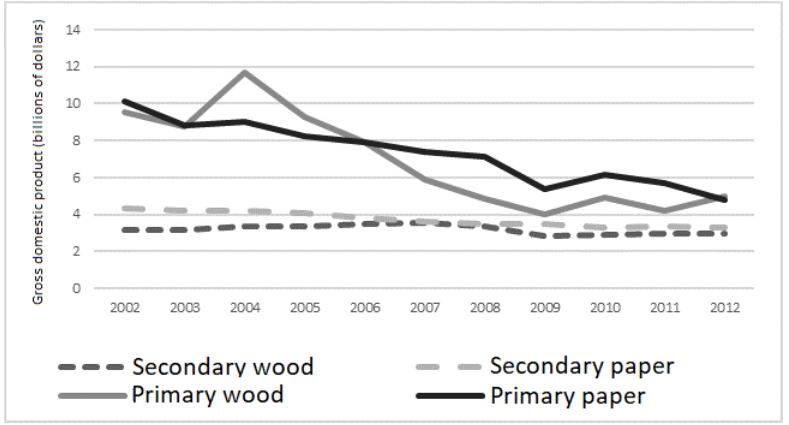
Source : Data NRCan,